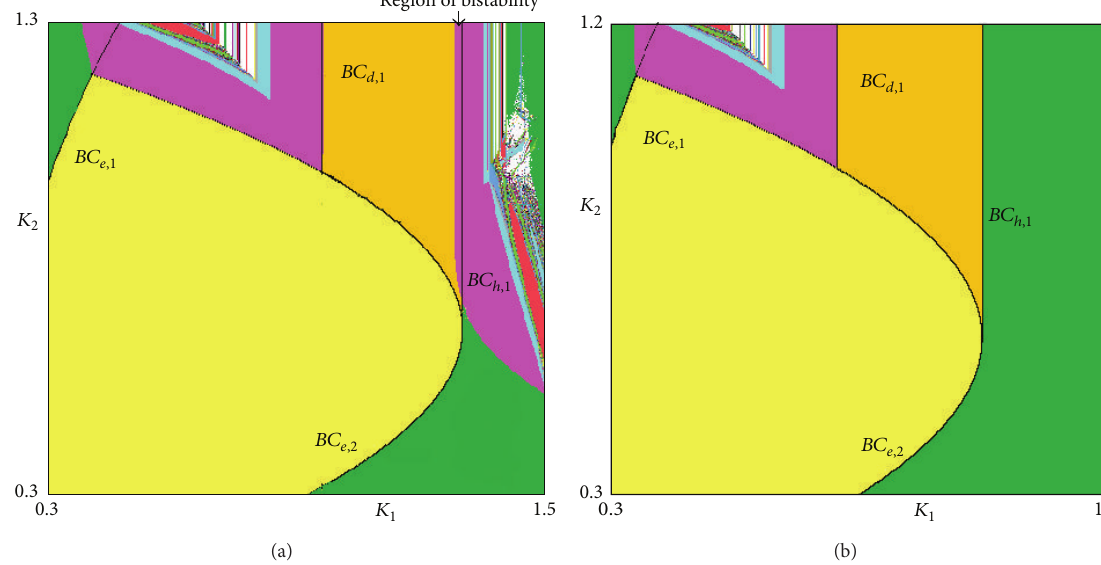
Figure 7: Two-dimensional bifurcation diagram in the (𝐾 1 , 𝐾 2 ) -parameter plane for map 𝑇 at 𝑁 1 = 1.5 , 𝜏 1 = 𝜏 2 = 4 , and 𝛾 1 = 𝛾 2 = 1 . Panel (a) 𝑁 2 = 1.3 . Panel (b) 𝑁 2 = 1.2 . The meaning of the colored regions is as in Figure 2.